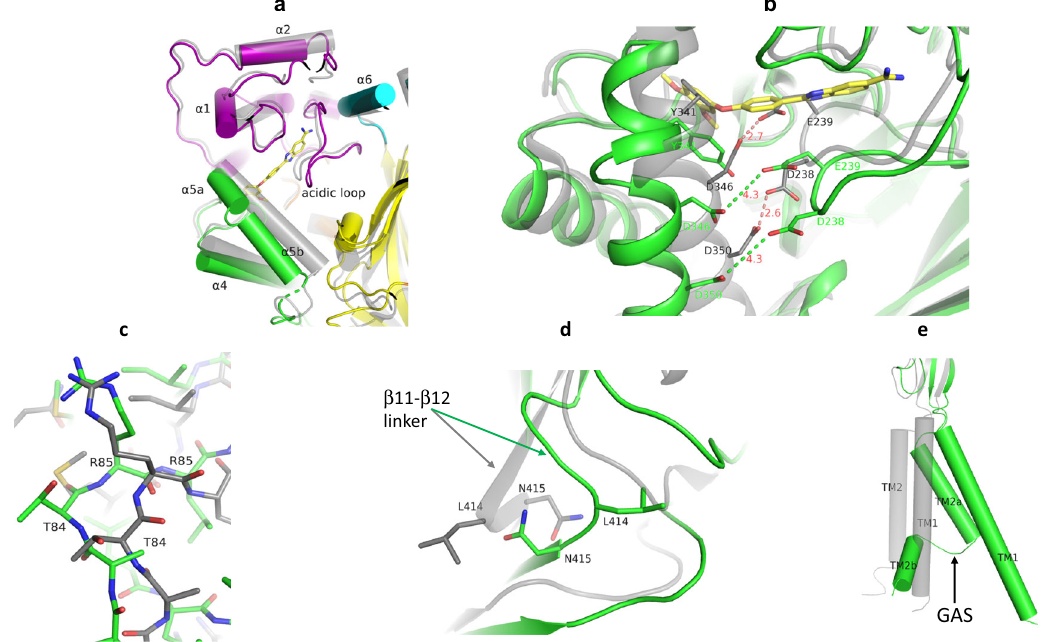
Fig. 9 Key conformations of the Δ ASIC1/JNJ-799760 complex. a Superposition of Δ ASIC1/JNJ-799760 (colored by domain) and 3S3W apo (gray/ transparent) structures. Binding of JNJ-799760 causes outward pivots of α 4 and α 5 (split into α 5a and α 5b) and displacement of the acidic loop. b Superposition of Δ ASIC1/JNJ-799760 (green) and 3S3W (gray/transparent) near the acidic pocket. Note the increased side-chain distance of D238 – D350 and of E239 – D346. Numbers are in Å. Note that E239 and Y341 side chains in 3S3W clash with JNJ-799760. c Superposition of Δ ASIC1/JNJ-799760 (green) and 3S3W (gray) for a portion of the β 1 – β 2 linker. Note the ~180° fl ip of the T84 – R85 peptide bond orientation. d Superposition of Δ ASIC1/JNJ- 799760 (green) and 3S3W (gray) for a portion of the β 11 – β 12 linker. Note the swap of L414 – N415 side-chain orientations and displacements of L414 and β 11 – β 12 linker due to JNJ-799760 binding. e Comparison of chain A TM domains of Δ ASIC1/JNJ-799760 (green) and 3S3W (gray). Note the extended GAS belt conformation and TM2b domain swap in Δ ASIC1/JNJ-799760.